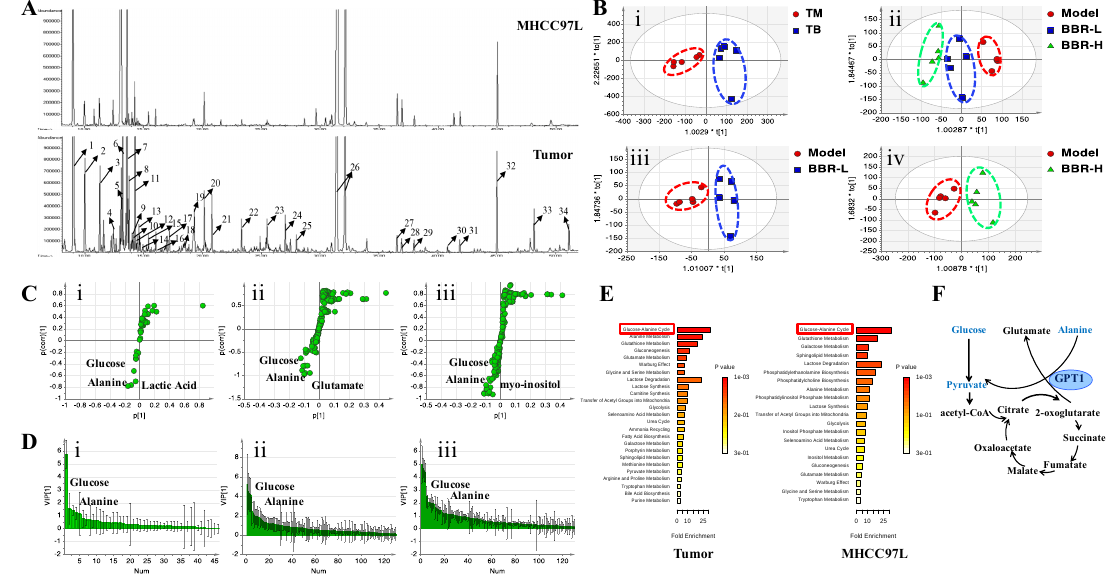
Figure 5. BBR mediated metabolic fluctuations primarily by regulating the glucose–alanine cycle in HCC. ( A ) The typical GC / MS (gas chromatography / mass spectrometry) TICs (total ion chromatograms) of tumor and cell samples. 1, Lactate; 2, Alanine; 3, 3-Hydroxybutyric acid; 4, Valine; 5, Urea; 6, Ethanolamine; 7, Glycerol; 8, Phosphonic acid; 9, Isoleucine; 10, Proline; 11, Glycine; 12, Butanedioic acid; 13, Pentadecane; 14, Uracil; 15, Serine; 16, Threonine; 17, beta-Alanine; 18, Succinic acid; 19, Malic acid; 20, 5-Oxoproline; 21, Hydroxyproline; 22, Glutamate; 23, Tetracosane; 24, Phosphorylethanolamine; 25, Citric acid; 26, Glucose; 27, Talose; 28, Palmitic Acid; 29, Myo-Inositol; 30, Oleic acid; 31, Stearic acid; 32, Tetracosane (IS); 33, 1-Monopalmitin; and 34, Glycerol monostearate. ( B ) The OPLS-DA (orthogonal partial least squares-discriminant analysis) score plots based on the data derived from the tumor and MHCC97L samples after BBR treatment ( n = 5). (i) Tumor samples: Model vs. BBR; (ii) MHCC97L samples: Model vs. BBR-L (50 µ M) vs. BBR-H (100 µ M); (iii) MHCC97L samples: Model vs. BBR-L (50 µ M); and (iv) MHCC97L samples: Model vs. BBR-H (100 µ M). The S-loading plots ( C ) and VIP (variable importance in the projection) score plots ( D ) based on the data derived from the tumor and MHCC97L samples after BBR treatment. (i) Tumor samples: Model vs. BBR; (ii) MHCC97L samples: Model vs. BBR-L (50 µ M); and (iii) MHCC97L samples: Model vs. BBR-H (100 µ M). ( E ) Metabolic pathway analyses of tumor and MHCC97L samples based on the variable metabolites of significant di ff erence after BBR treatment. ( F ) Schematic illustration of the metabolic flux involved in the glucose–alanine